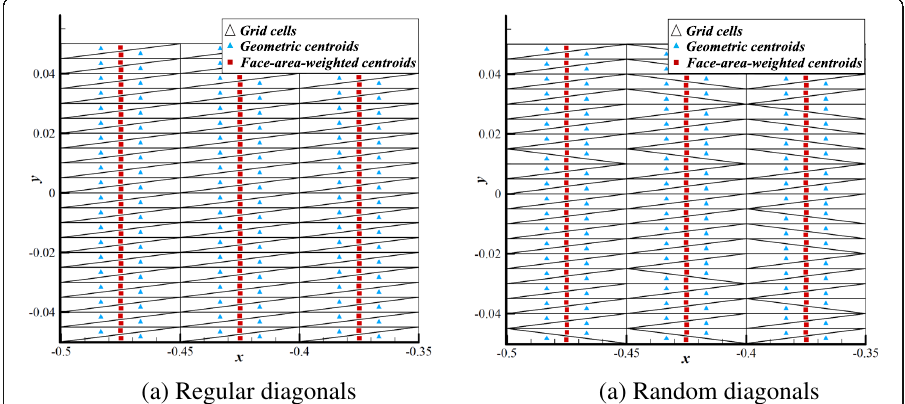
Fig. 33 Geometric and face-area-weighted centroids on grids with ( a ) regular and ( b ) randomly